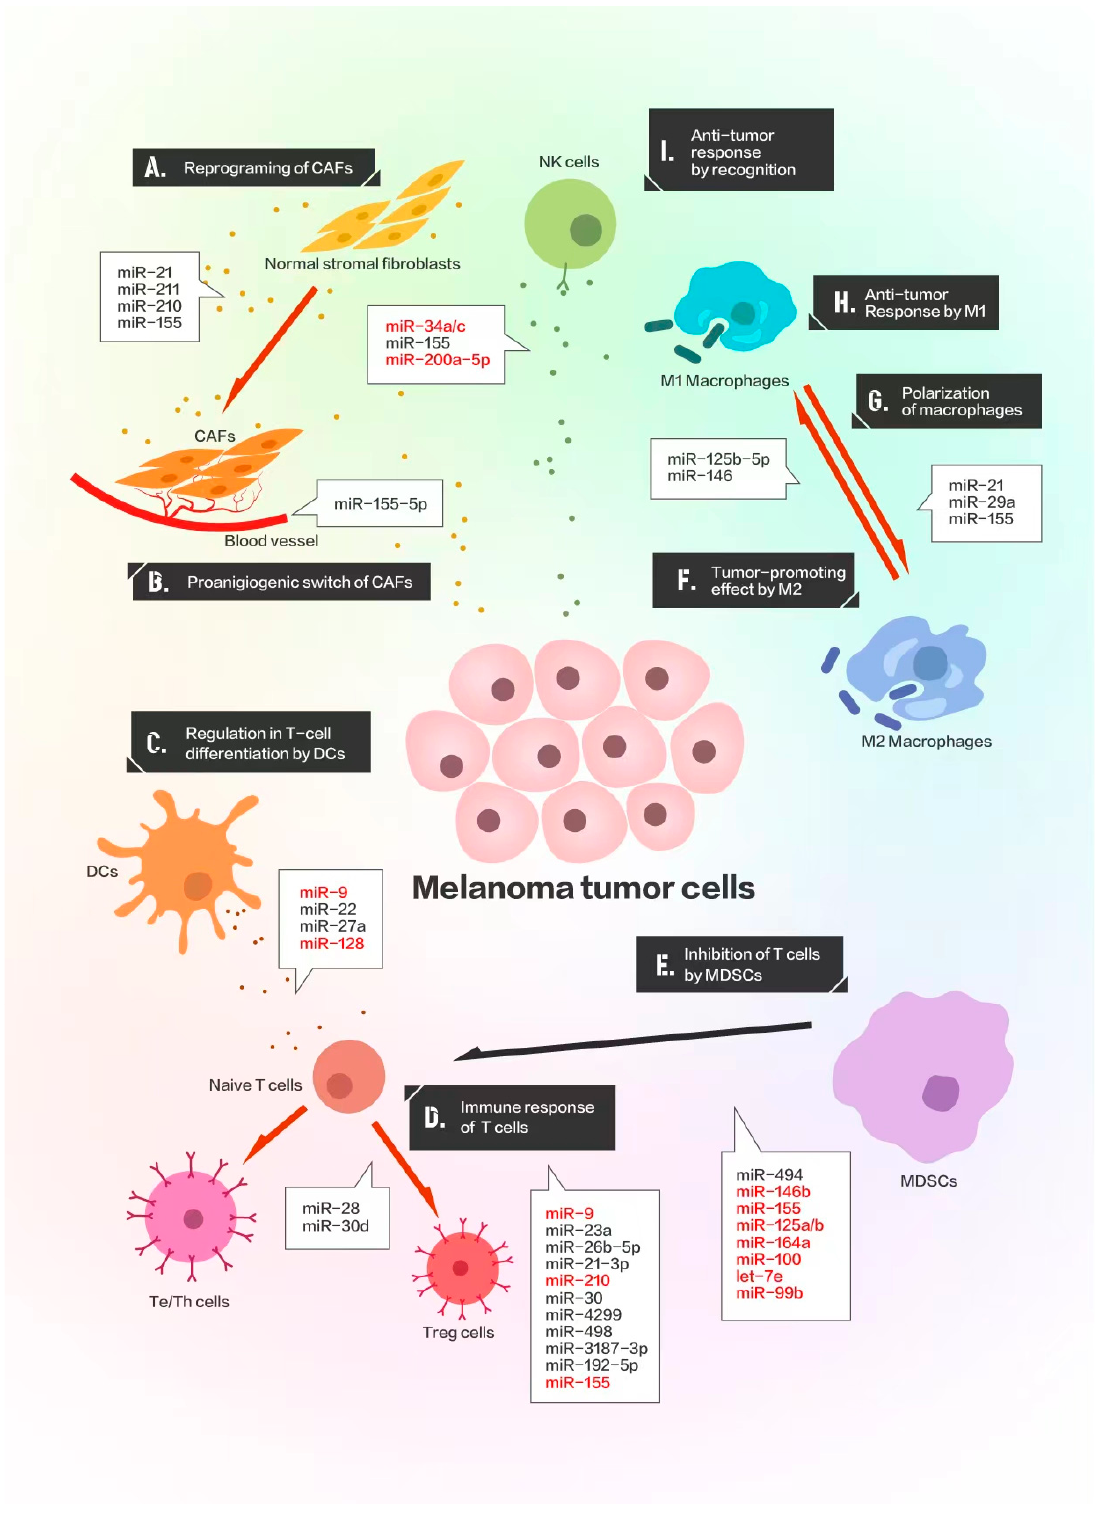
Figure 2. The roles of miRNA in the innate and adaptive immune systems. The miRNAs in black are oncogenic while those in red are tumor-suppressive.